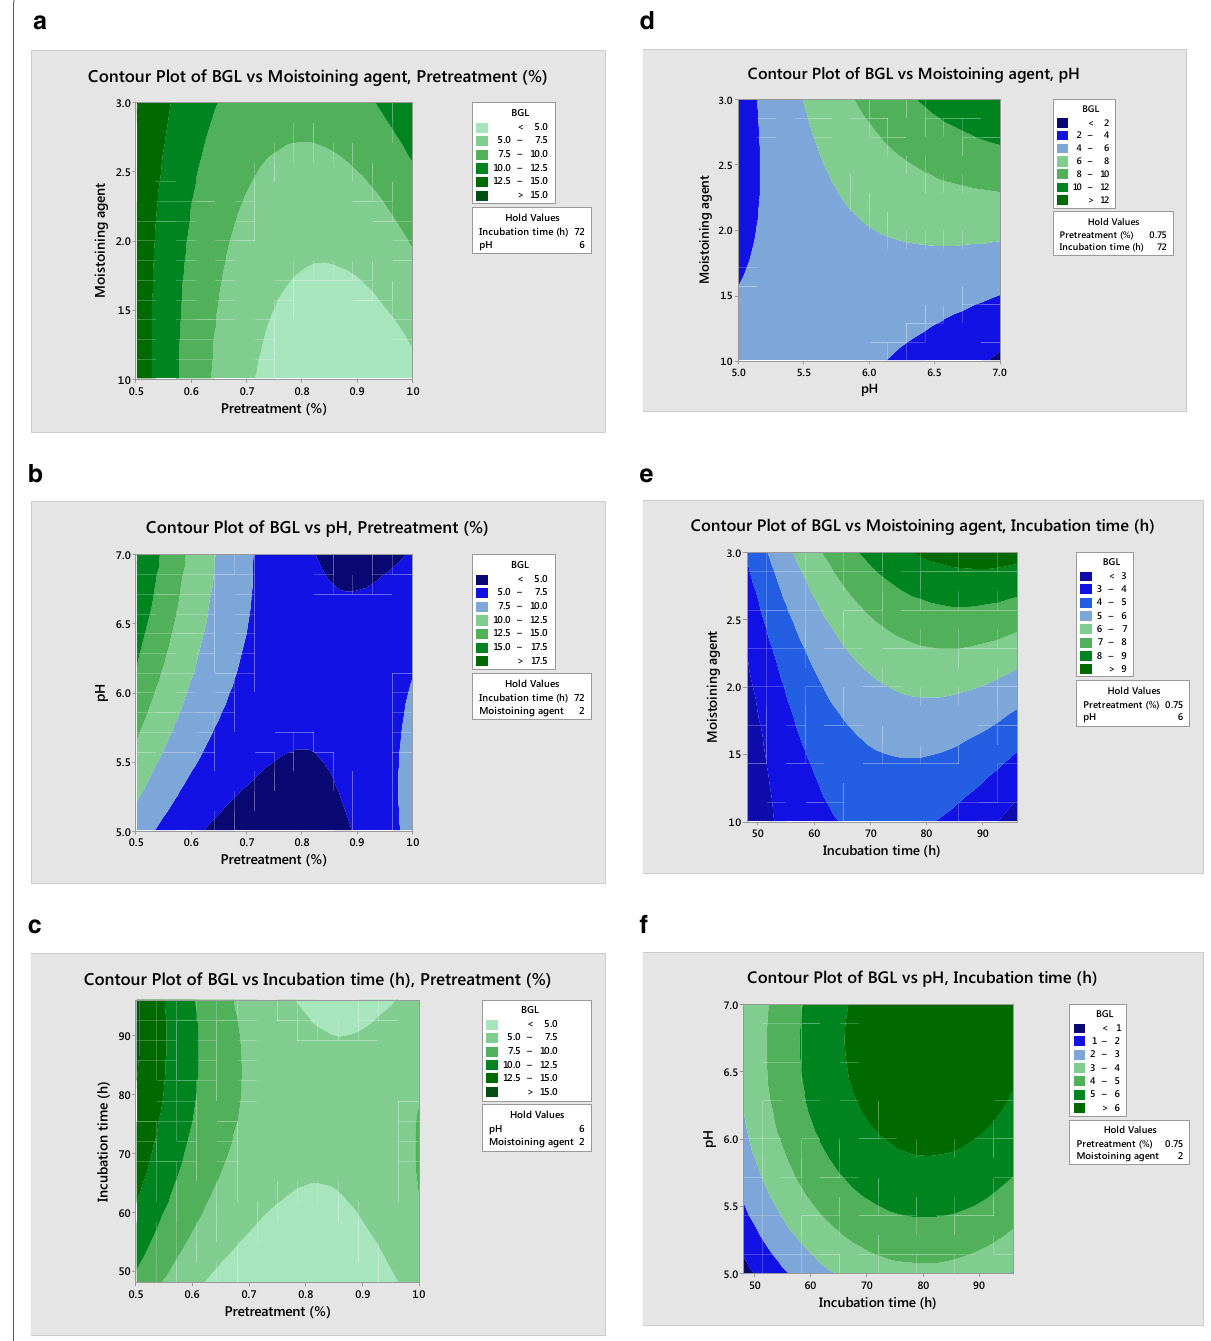
Fig. 2 Contour plots of BGL showing interaction between: a moistening agent and pretreatment, b moistening agent’s pH and pretreatment, c incubation time and pretreatment, d moistening agent and it’s pH, e moistening agent and incubation time, and f moistening agent’s pH and incubation